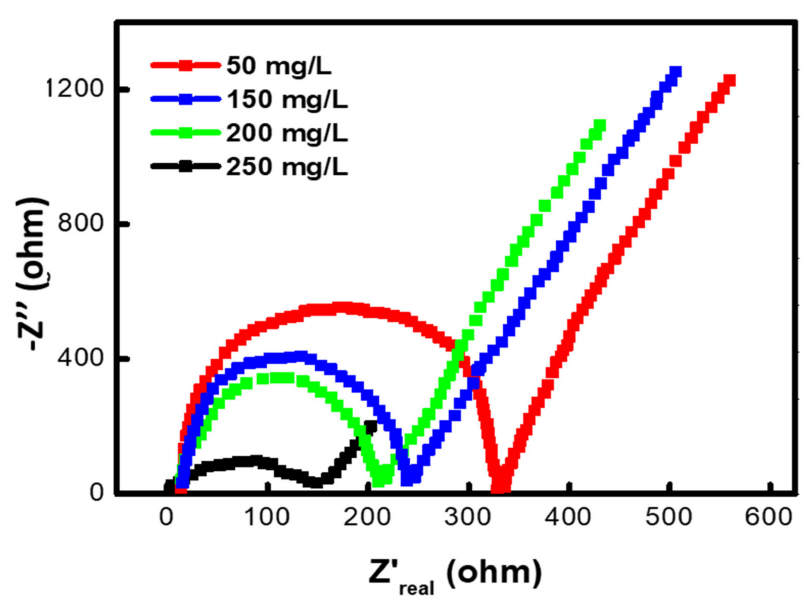
Figure 6. Analysis of the Nyquist plot of MFCs with different concentrations of MR dye on an anode chamber.